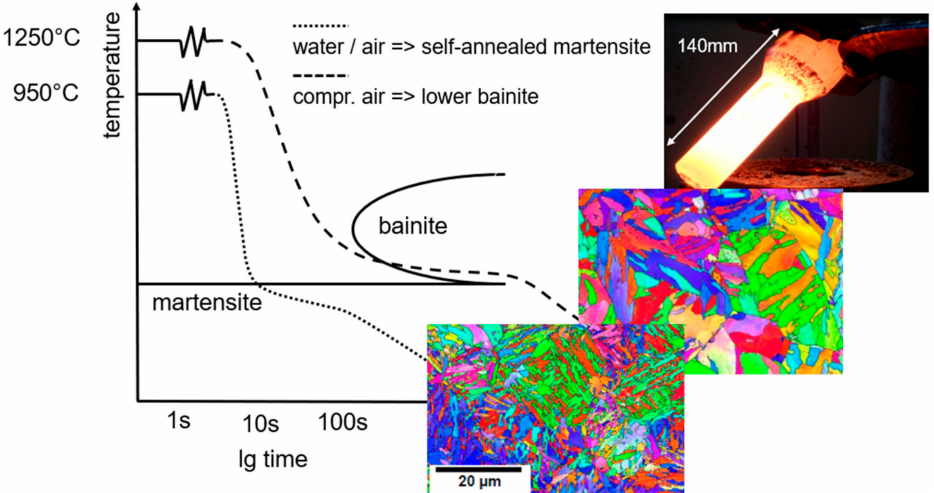
Figure 3. Thermomechanical processing by means of two different cooling routes in a schematic TTT diagram for the steel 16MnCrV7 7 applied to forward hot-extruded cylindrical bars (diameter 50 mm).